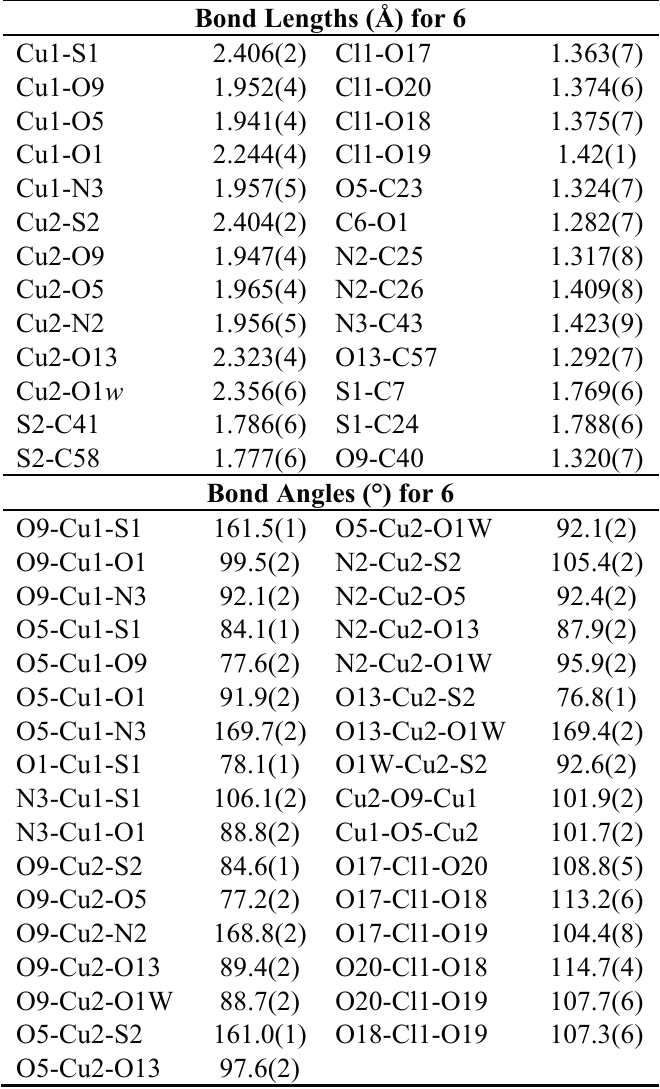
Table 2. Selected bond lengths (Å) and bond angles (°) for compound 6